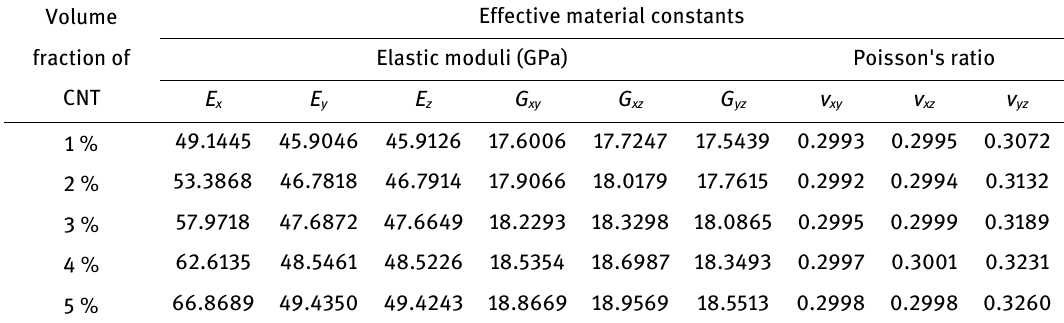
Table 5: Effective material constants of aligned and randomly-positioned ESF-reinforced